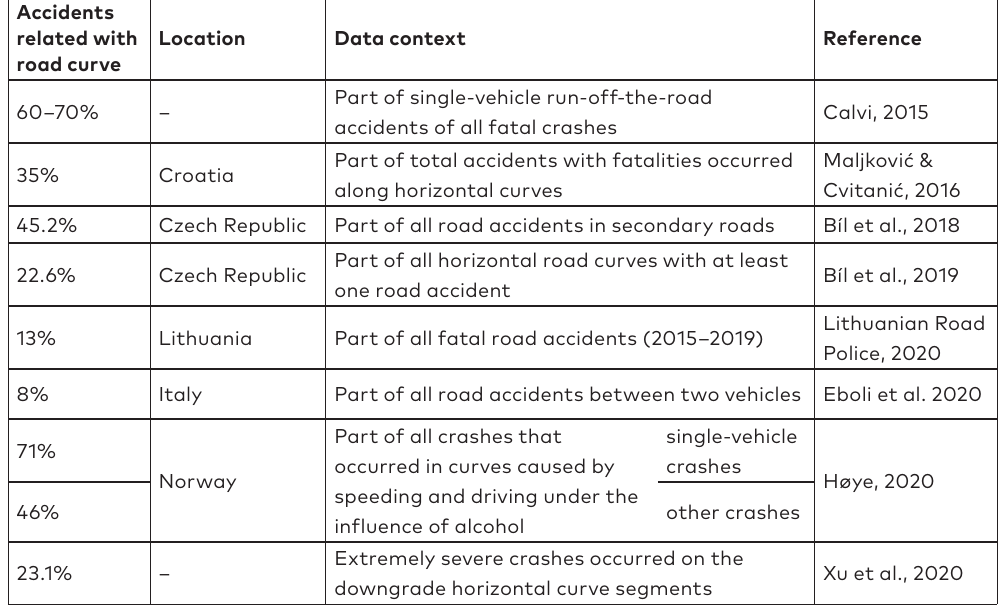
Table 1. Overview of accidents related to horizontal road curves in different